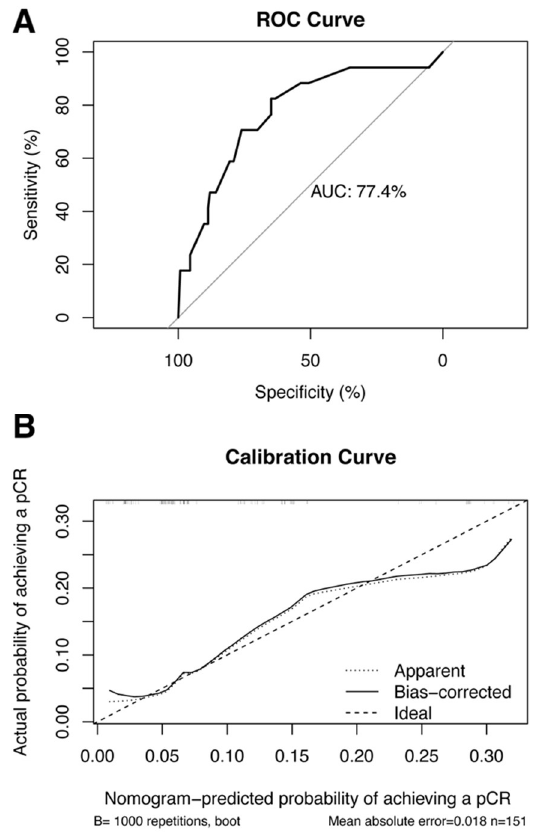
Figure 4. ( A ) ROC curves for the nomogram model to predict the probability of achieving pCR in the validation cohort. ( B ) Calibration curves for the nomogram model predicting the probability of achieving pCR in the validation cohort. Abbreviations: ROC, receiver operating characteristic; pCR pathological complete response; AUC, area under the curve.